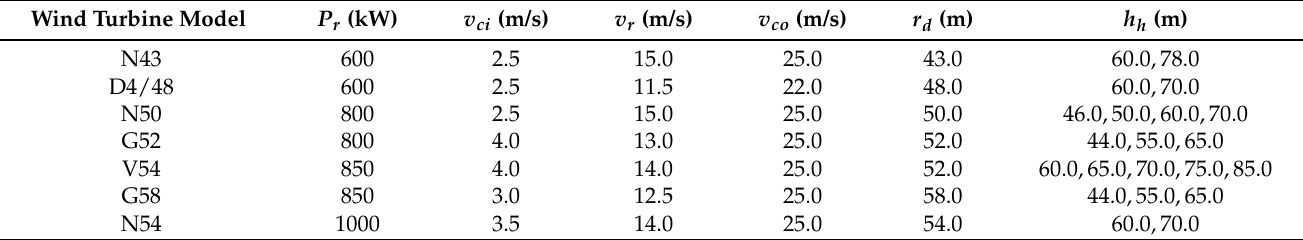
Table 4. Wind turbine models.